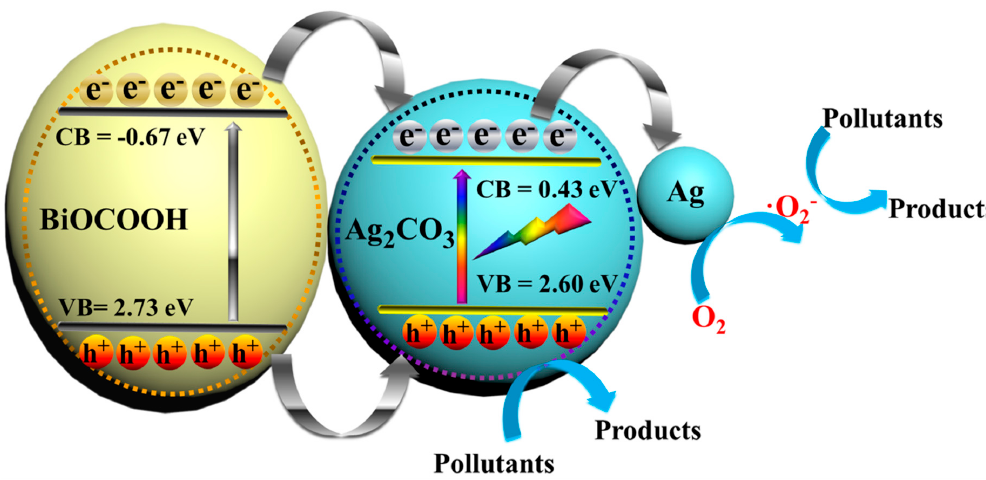
Figure 9. Proposed mechanism of pollutant removal over Ag 2 CO 3 /BiOCOOH under simulated sunlight.